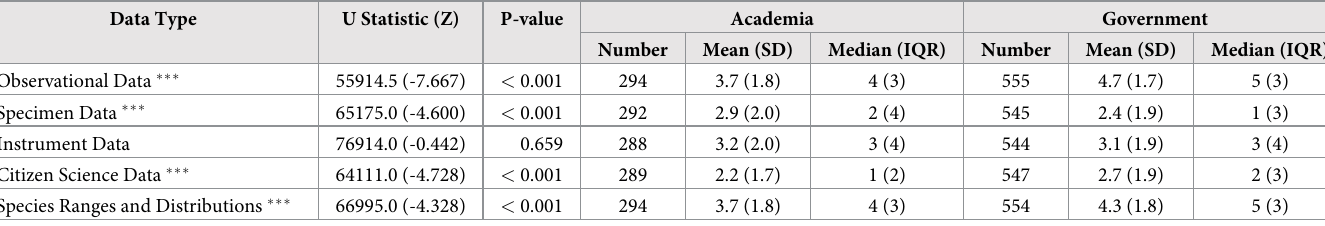
Table 7. Mann-Whitney U tests of frequency of use of different types of species occurrence data.